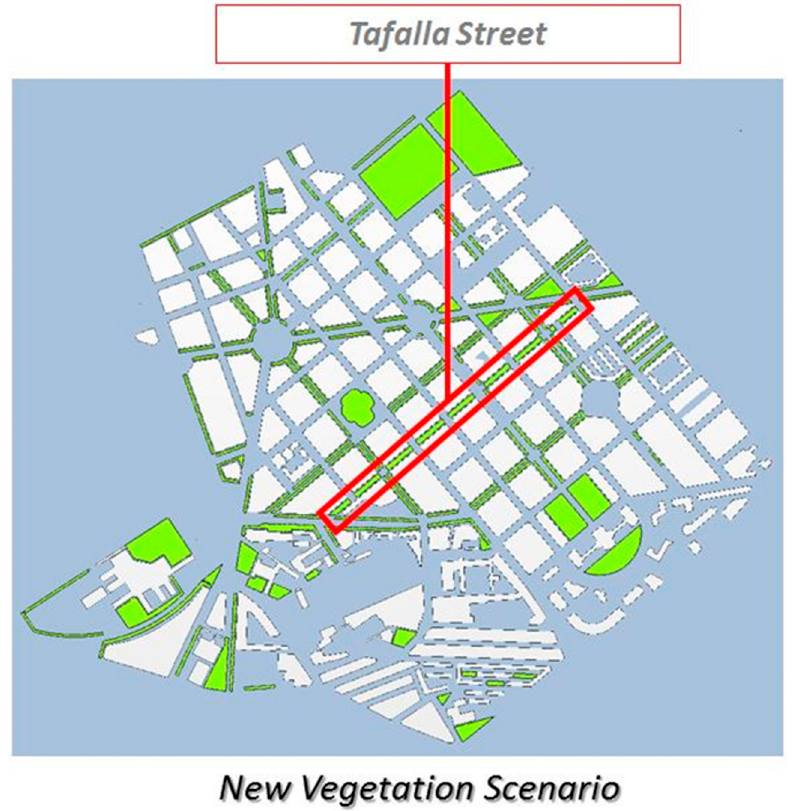
Figure 8. Location of modelled vegetation of New-1 and New-2 cases.